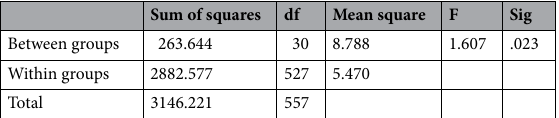
Table 2. One-way ANOVA for Titli longitude.